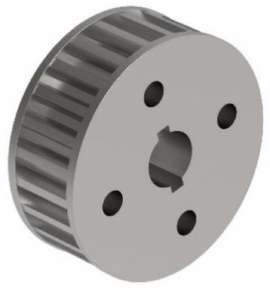
Figure 15. A driving gear.